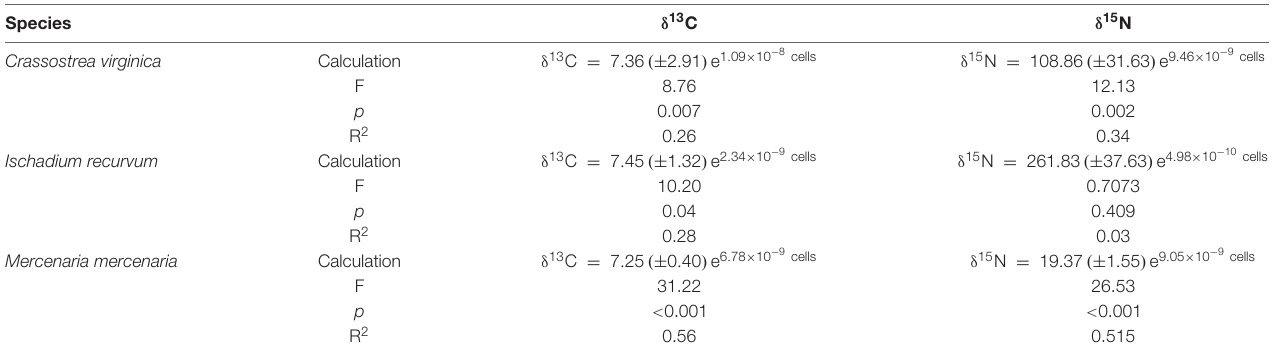
TABLE 5 | Nonlinear exponential regressions between the number of Aureoumbra lagunensis cells removed by the bivalves from the water after 60 min exposed to the experimental algal concentrations and isotope values of the whole bivalve flesh. Species